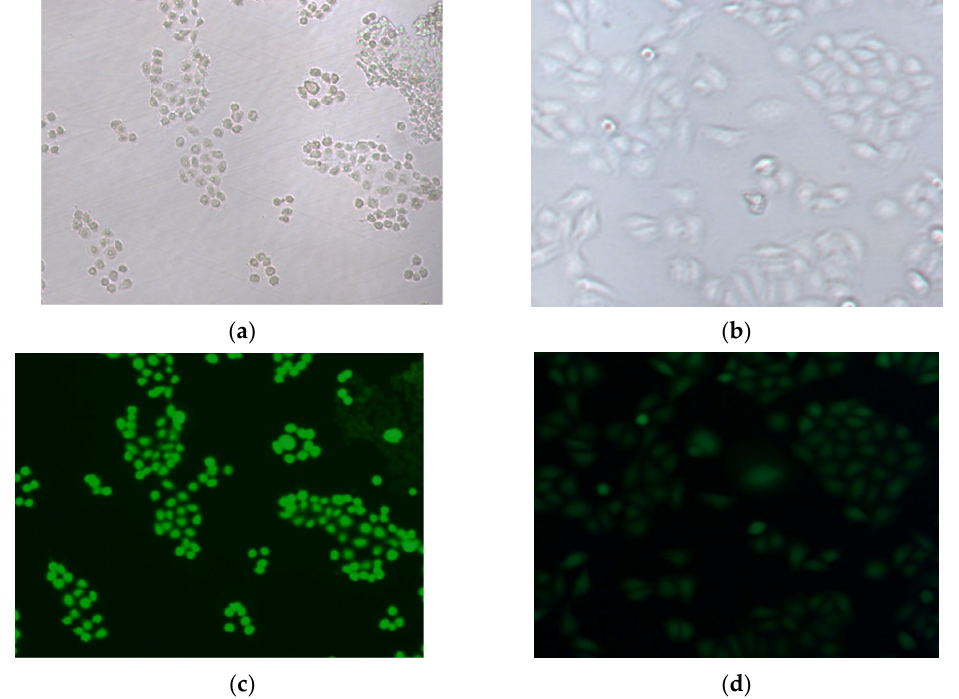
Figure 7. Cytotoxicity of dGMPSe ( a , c ) 6 h after administration into HeLa cells compared to dGMP control ( b , d ) observed by inverted microscopy. Both compounds were used at a concentration of 200 µM. Phase contrast is shown in panels ( a , b ), and fluorescence images after addition of SF7 probe (ex/em = 485/528 nm) are shown in panels ( c , d ). Images were taken at magnification × 20.